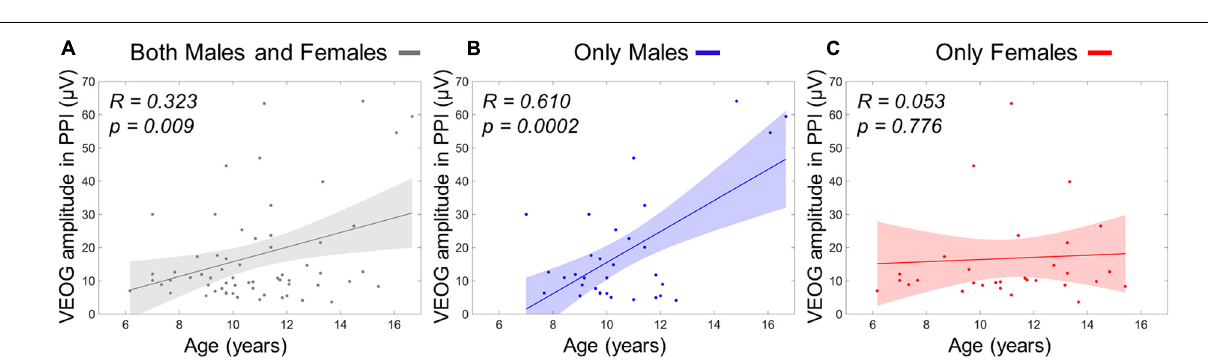
FIGURE 8 | Linear term of VEOG amplitudes in PPI correlating with age as scatterplots. (A) Age versus VEOG amplitudes in PPI in the whole population. (B) Age versus VEOG amplitudes in PPI in Males only. (C) Age versus VEOG amplitudes in PPI in females only. Color-shaded areas indicate the 95% confidence interval of the best-fitting